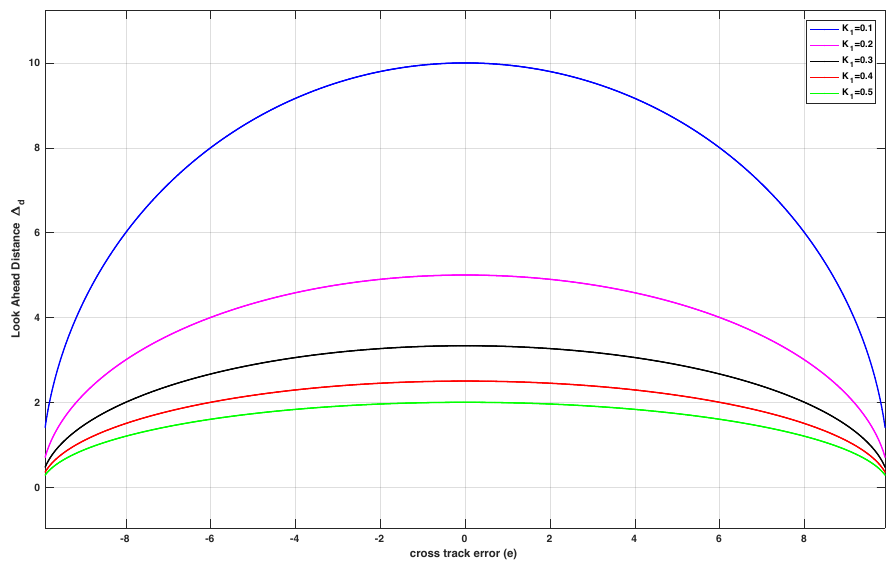
Figure 11. Look-ahead distance plotted against the cross-track error with different gains.